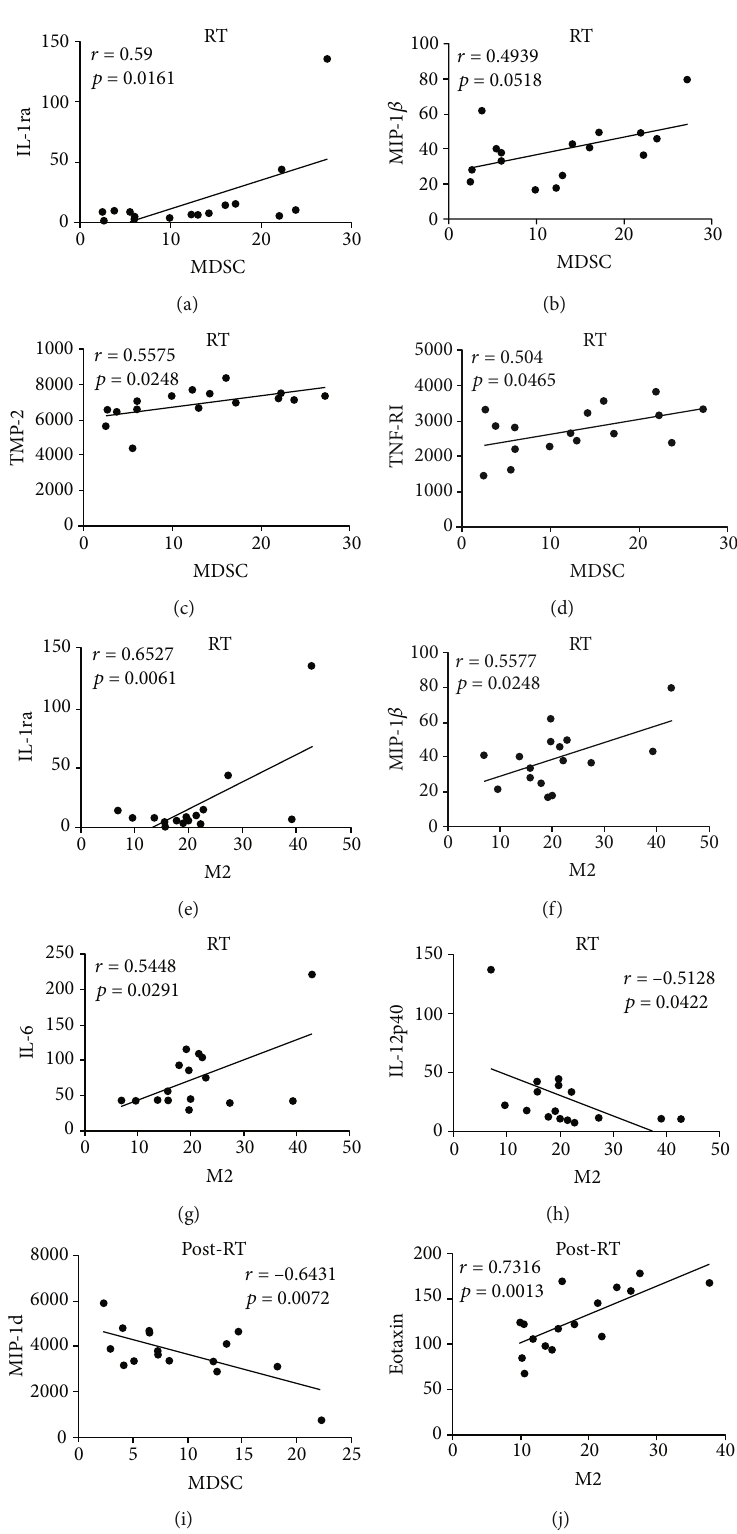
Figure 8: Correlation between the expressions of plasma cytokines and MDSCs as well as CD68 + CD163 + M2-like macrophages of NSCLC patients in RT and post-RT groups. (a – d) The expressions of MDSCs were correlated with IL-1ra, MIP-1 β , TIMP-2, and TNF RI in NSCLC patients during radiotherapy. (e – h) The expressions of CD68 + CD163 + M2-like macrophages were correlated with IL-1ra, MIP-1 β , IL-6, and IL-12p40 in NSCLC patients during radiotherapy. (i) Correlation between the expression of MDSCs and MIP-1d after radiotherapy. (j) Correlation between the expression of M2-like macrophage and eotaxin after radiotherapy. Data were analyzed by Pearson ’ s correlation